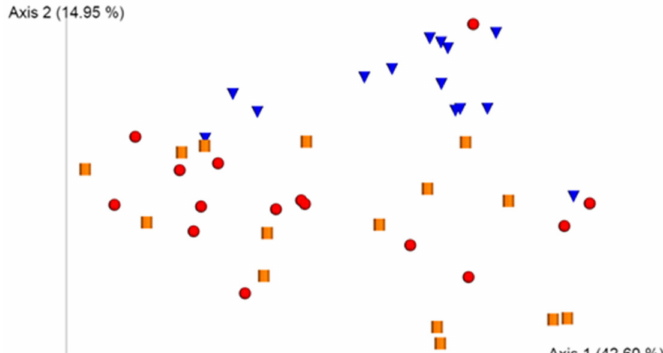
Figure 1. UniFrac model for the study groups. UniFrac model for the three study groups. Sam- ples appear as red spheres (Group CDI), inverted blue cones (Group CTRL), and yellow cylinders (Group P).